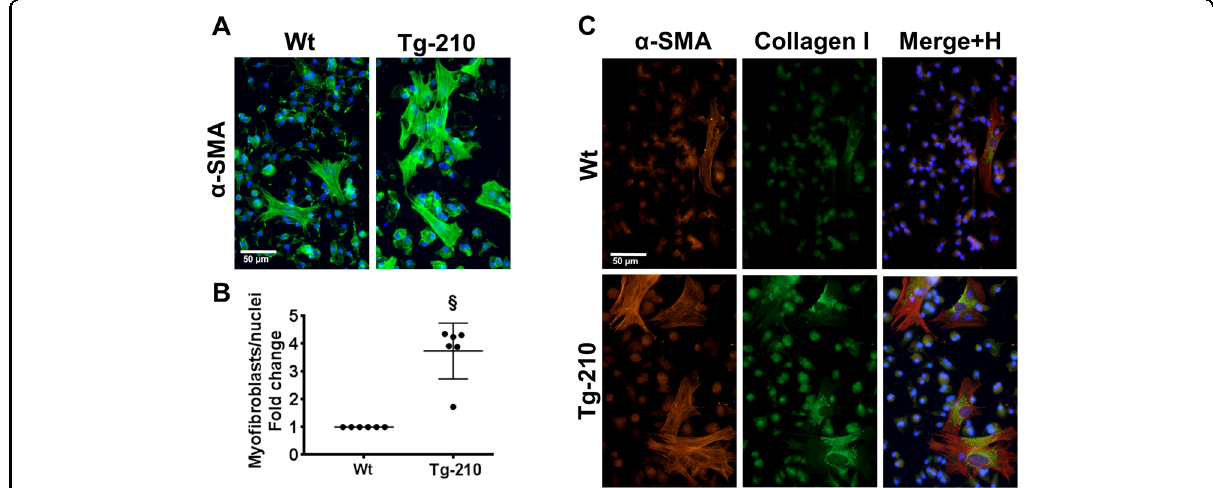
Fig. 7 Cell culture of Tg-210 BM-derived macrophages exhibit a pro- fi brotic phenotype. A Representative immuno fl uorescence staining for α -SMA (green) of BM-derived macrophages at day 7 + 7 of culture. Images are presented as merge, nuclei were stained by Hoechst (blue). Magni fi cation ×400, calibration bar 50 µm. B Quanti fi cation of myo fi broblasts/total nuclei, represented as fold change versus Wt ( n = 4, § P < 0.0001). C Representative images of double immuno fl uorescence staining for α -SMA and Collagen I of BM-derived macrophages at day 7 + 7 of culture. The merges include the nuclear staining by Hoechst (H) (blue). Magni fi cation ×400, calibration bar 50